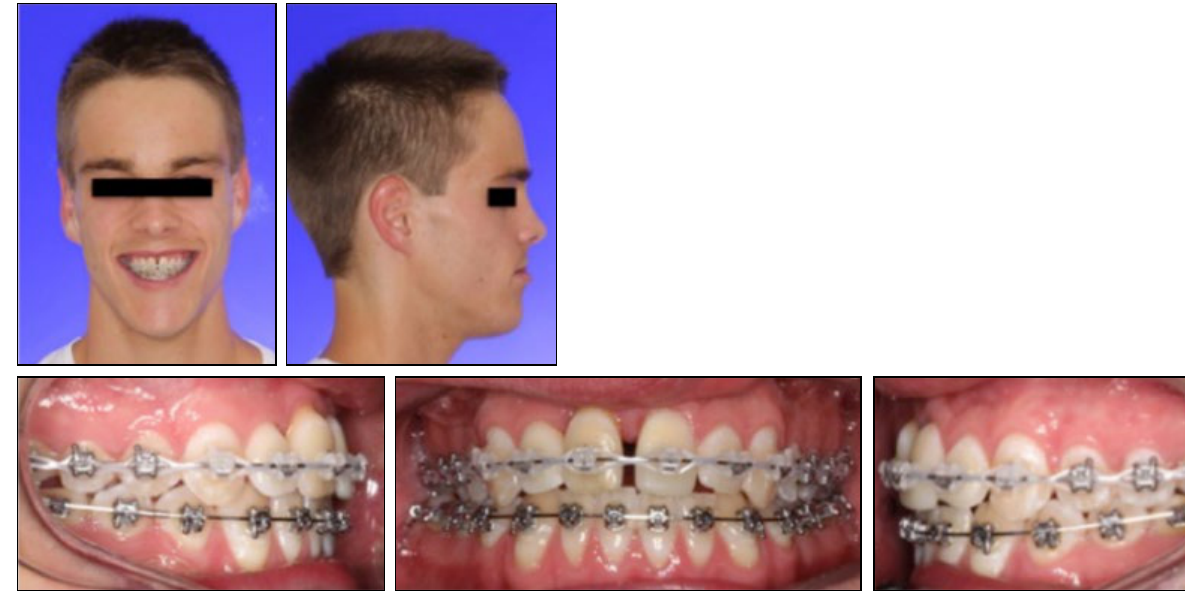
Figure 7. Mid-treatment photos after both surgeries